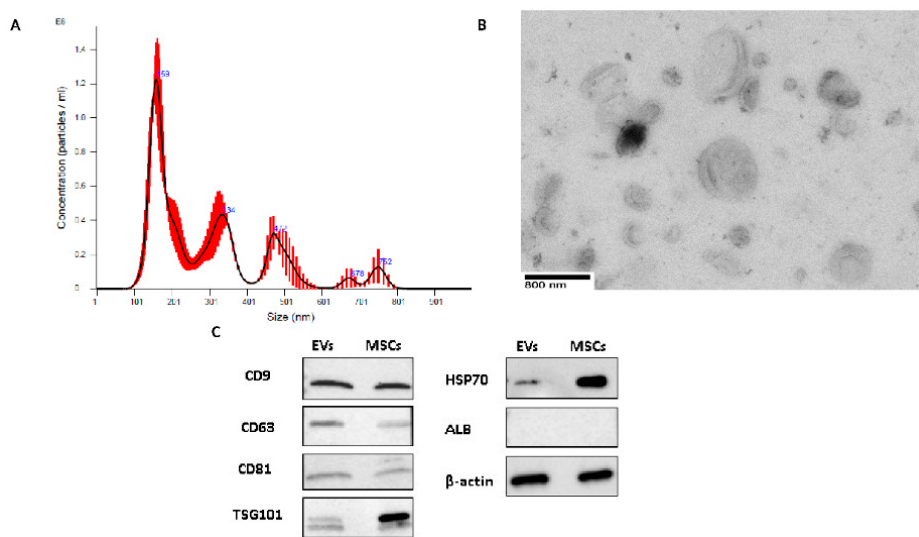
Figure 1. Extracellular vesicle (EV) characterizations. ( A ) A typical profile of human MSC-EV fractions by NanoSight analysis. ( B ) A typical profile of electron micrographs of human MSC-EVs (scale bar = 800 nm; magnification: 14,000×). ( C ) Representative western blot analyses of CD81, CD63, CD9,